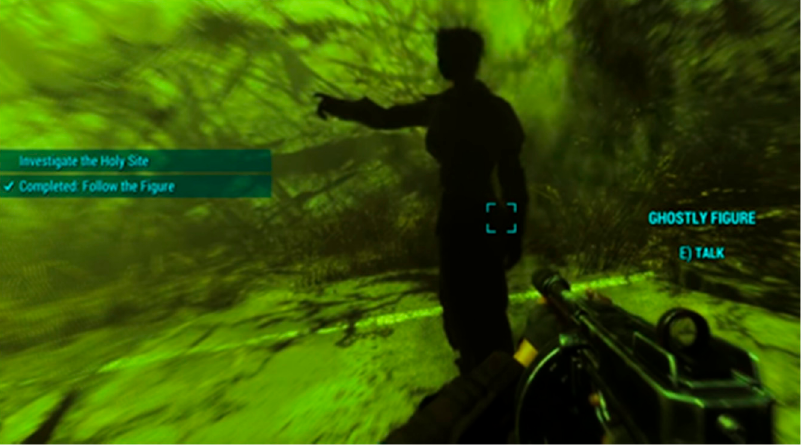
Figure 7. The MoThEr aids the player in their quest to become a member of the Church of the Children of Atom.